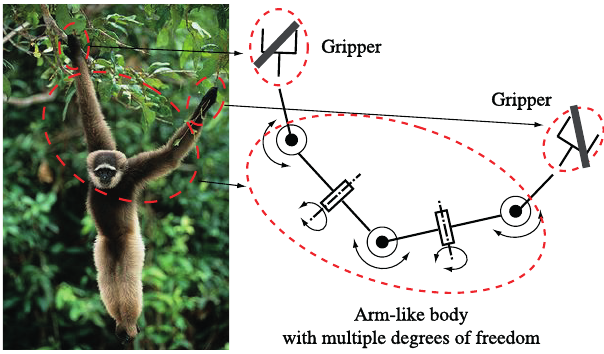
Figure 1. The inspiration for biped climbing